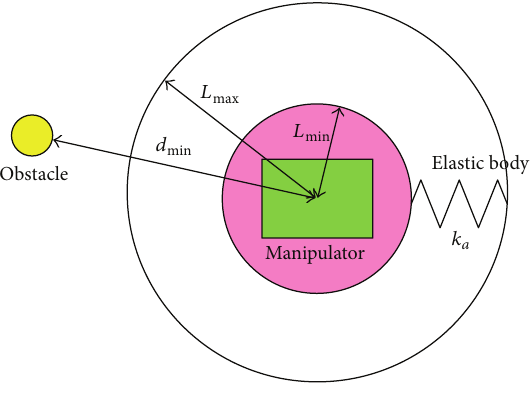
Figure 4: Virtual